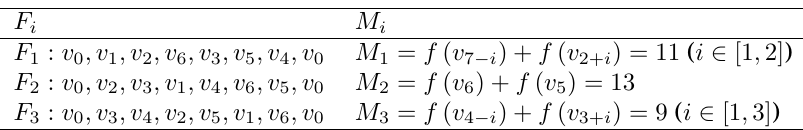
Table 2: A Hamiltonian factorization of K 7